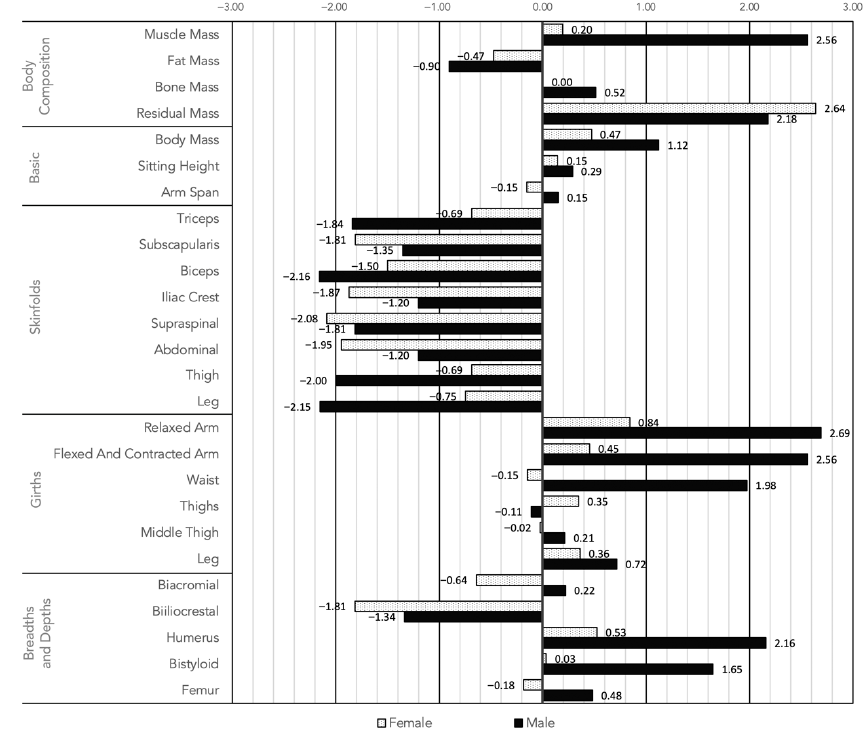
Figure 3 shows the representation of the Z ‐ Scores, where it was observed that the muscle mass of men was 2.56 standard deviations above the Phantom model, which places it above the 95% confidence interval (95% CI), such in the girth of the contracted arm; Likewise, most skinfolds, both in men and women, were found between one and two standard deviations below the general population, which places them below the 68% CI.